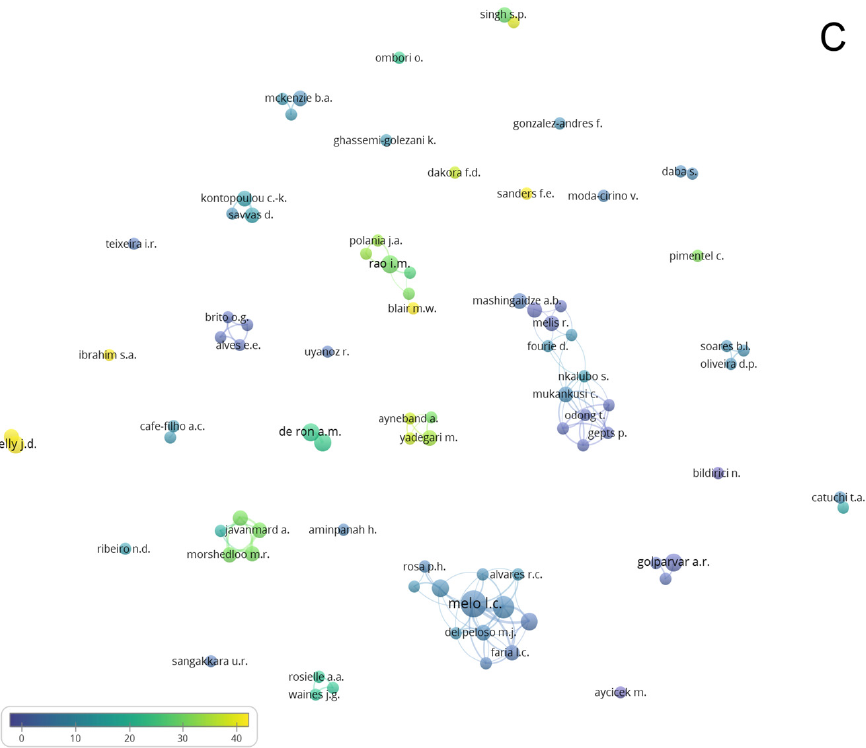
Figure 7. Network map produced by VOSviewer with the collaborations and the number of documents of the authors with more than 2 documents in the 228 publications included in the systematic review. The size of the circle under the author’s name indicates the number of publications. The connection of the authors with a line shows co-authoring. ( A ) Network visualization of authors’ collaborations. Different colours represent different clusters of collaborative author schemes. ( B ) Thematic evolution of authors in the field of research on agronomic practices that increase yield and quality of common bean coloured by the publication year, or ( C ) coloured by the citations received.